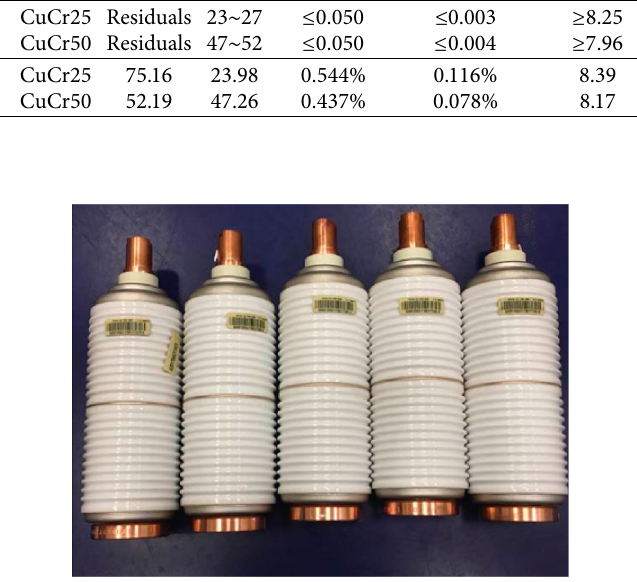
Figure 26: Vacuum interrupter assembled by CuCr alloy prepared by this process